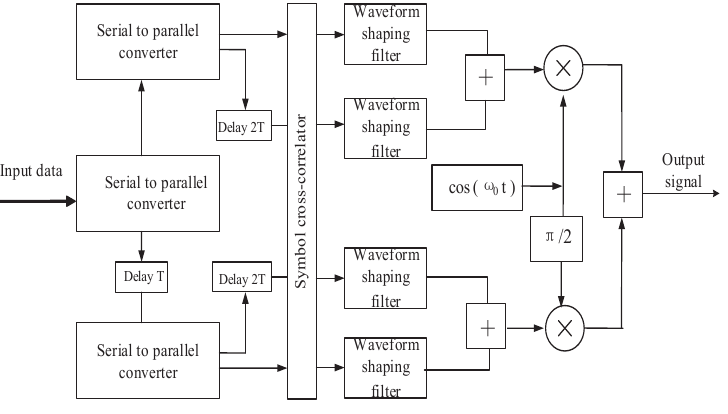
Figure 6. Block diagram of the quadrature modulation system.